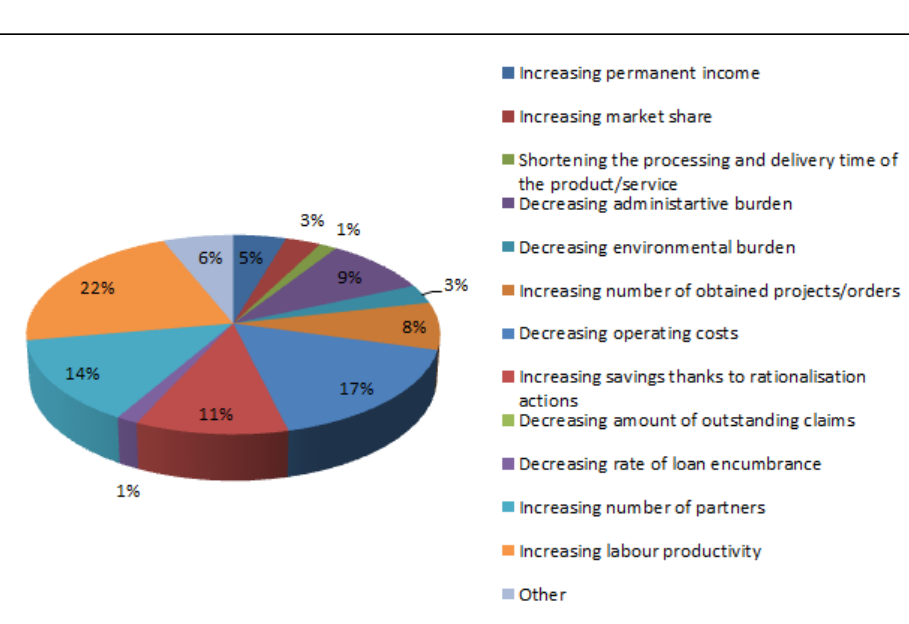
Fig. 7 Results of question 5 c) Impact of participation in NQASR